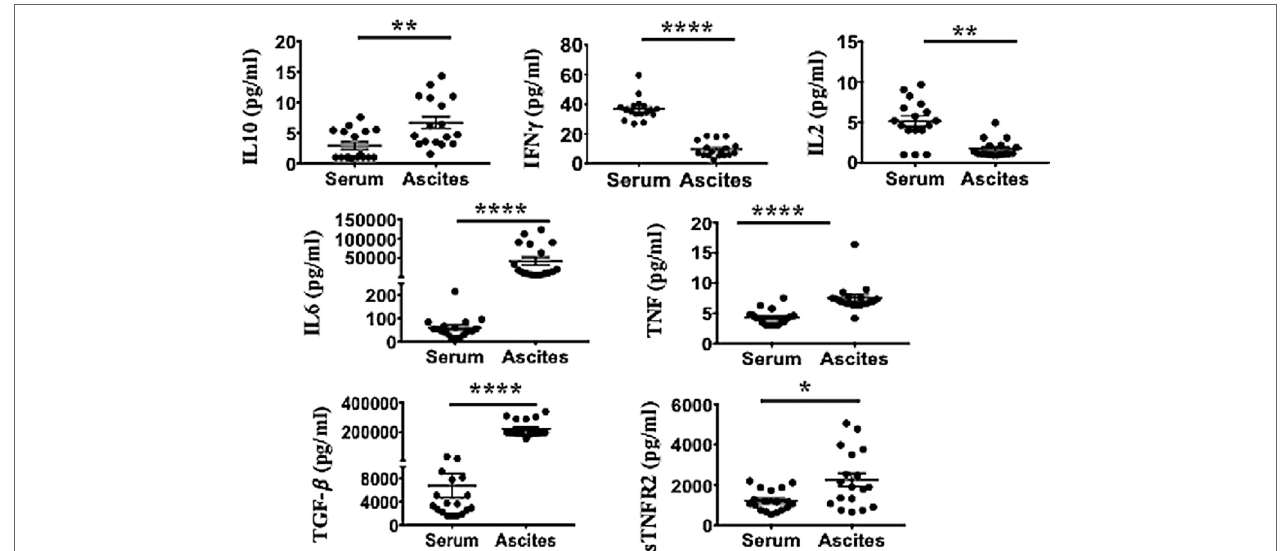
FigUre 5 | Ascites of epithelial ovarian cancer (EOC) patients contain higher levels of immunosuppressive (sTNFR2, IL-10 and TGF- β ) and pro-inflammatory cytokines [interleukin 6 (IL-6) and TNF], but lower levels of IFN- γ compared to their respective serum. Cell-free ascites and corresponding peripheral blood serum were collected from 18 patients with advanced EOC and soluble biomarkers including IL-10, IFN- γ , IL-2, IL-6, TNF, TGF- β , and sTNFR2 quantified using multiplexed bead-based immunoassay. * p < 0.05, ** p = 0.001–0.01, *** p = 0.0001–0.001, *** p < 0.0001, Wilcoxon matched-paired t -test (error